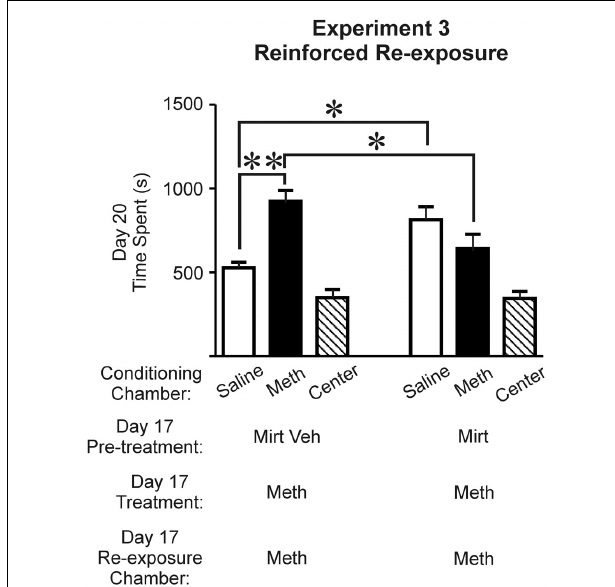
FIGURE 4 | Methamphetamine (Meth) administered in conjunction with mirtazapine during re-exposure to the Meth-paired chamber on day 17 inhibited the expression of CPP tested on day 20. Rats administered mirtazapine vehicle + Meth ( n = 14, left set of bar graphs), expressed CPP ( post hoc Newman–Keuls, p < 0.01) whereas rats that received a mirtazapine + Meth ( n = 7, right set of bar graphs) did not demonstrate a preference for the Meth chamber ( post hoc Newman–Keuls, p > 0.05). In addition, the time spent in the Meth-paired chamber was significantly reduced after Mirt pre-treatment compared to vehicle pre-treatment ( post hoc Newman–Keuls, p < 0.05).Time spent in the center chamber is presented for qualitative comparisons, and was not included for the one-way ANOVA statistical analysis. Saline, saline-paired chamber; Meth, methamphetamine-paired chamber; Center, central neutral chamber; MirtVeh, mirtazapine vehicle (water pH ∼ 6.3; 1ml/kg); Mirt, mirtazapine (5mg/kg); M, methamphetamine